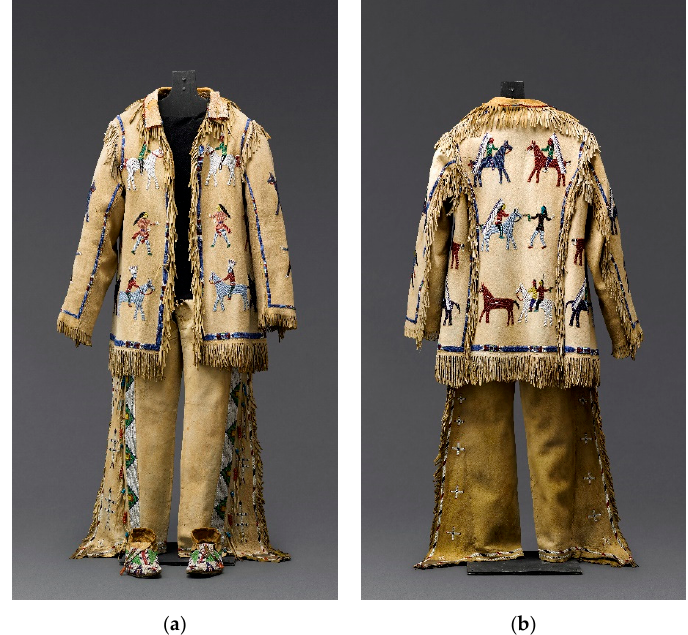
Figure 2. Regalia of Itˇh ú ŋ kasa ŋ Glešk á . ( a ) front of jacket, pants, and moccasins, ( b ) back of jacket and pants. Late nineteenth or early twentieth century. Buckskin and beadwork. Mus é e franco-am é ricaine du ch â teau de Bl é rancourt. Photograph taken by Adrien Didierjean and used by permission of RMN-Grand Palais / Art Resource,